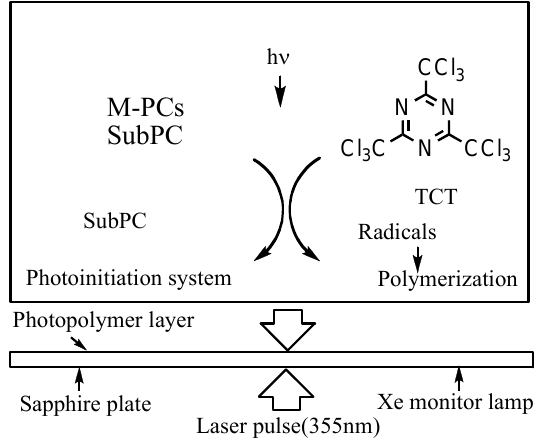
Figure 15. Laser flash photolysis in film.